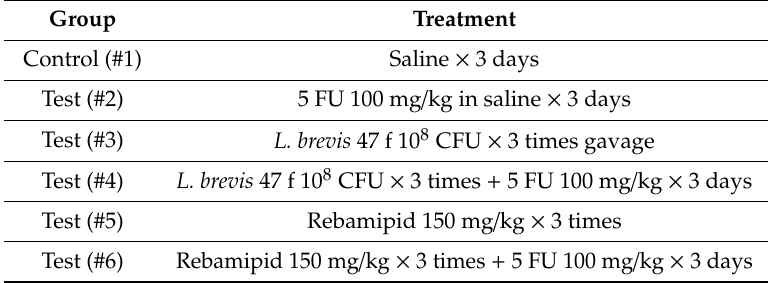
Table 1. Animal groups and treatments. 5 FU;